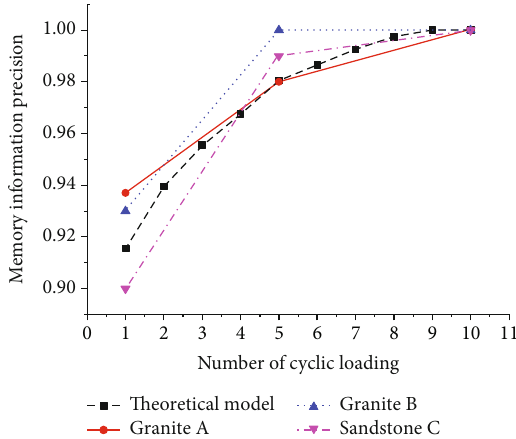
Figure 14: Comparison of memory precision between the theoretical model and the experiment.